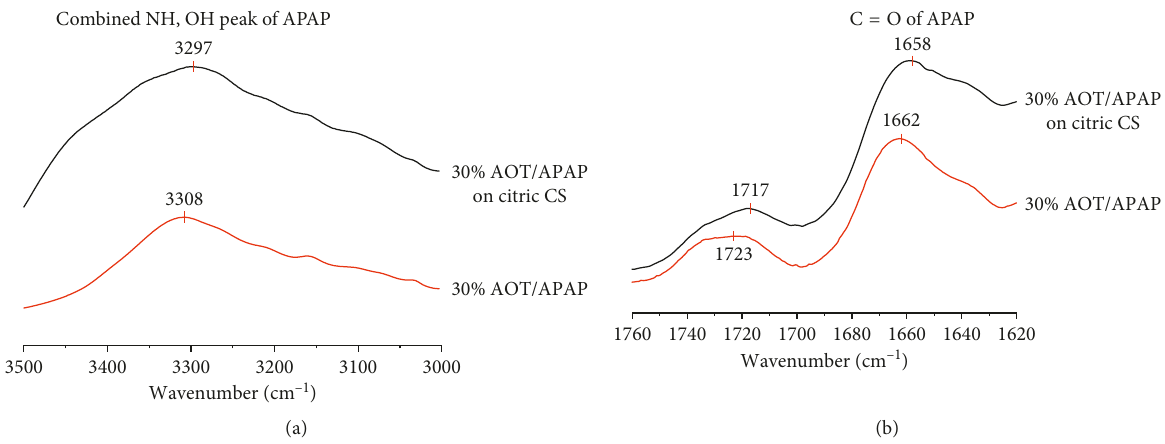
Figure 4: IR spectra of the AOT-APAP-citric CS system in the (a) combined N–H and O–H stretch region of APAP and (b) combined C � O stretch region of AOT and citric acid and C � O stretch region of APAP.